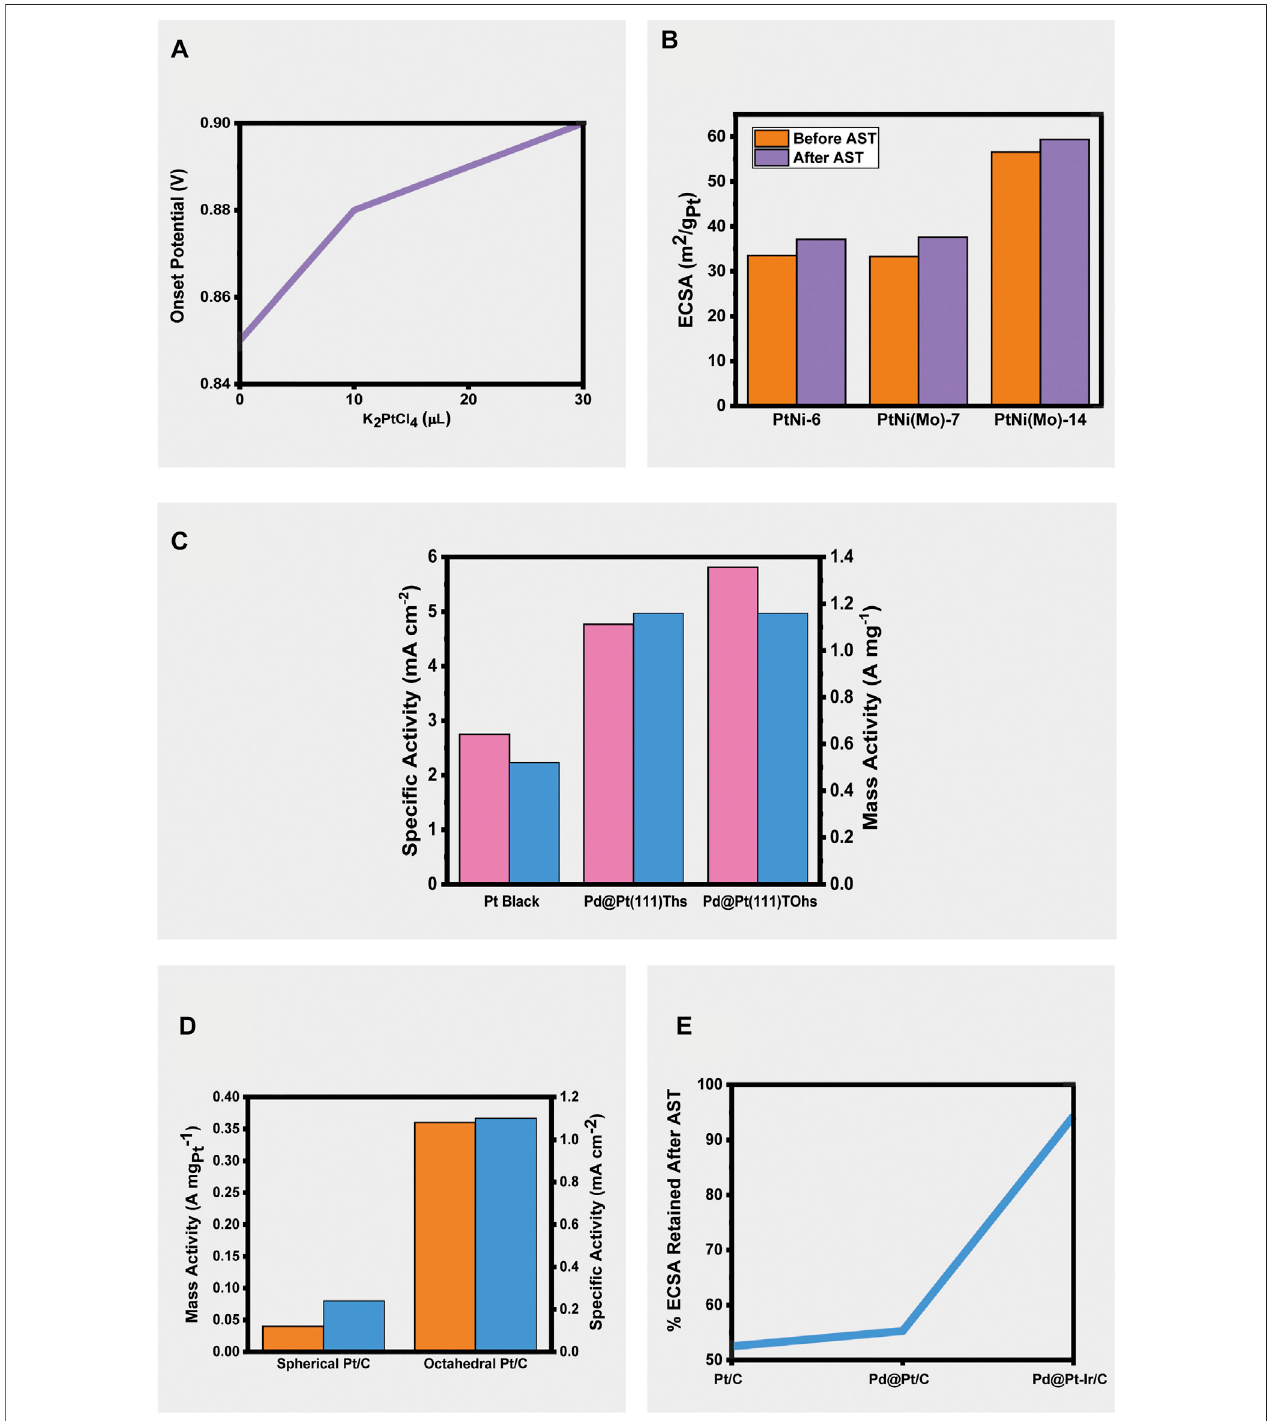
FIGURE 2 | (A) Change in onset potential of Au@Pt CCB NCs with increasing platinum precursor amount (10), (B) Change in ECSAs of PtNi-6, PtNi(Mo)-7, and PtNi(Mo)-14 after 10,800 cycles of accelerated stress testing (17), (C) Comparison of speci fi c and mass activities of Pt Black, Pd@Pd(111)Ths, and Pd@Pt(111)TOhs (13), (D) Comparisonofmassandspeci fi cactivitiesofsphericalandoctahedralPt/C(16), (E) PercentofECSAretainedafteracceleratedstresstestingforcommercialPt/ C, Pd@Pt icosahedra/C and Pd@Pt-Ir Icosahedra/C (18).